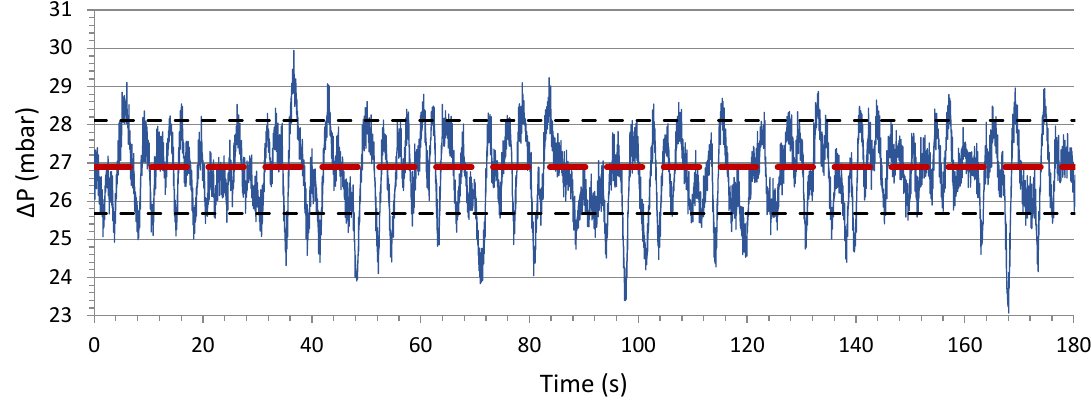
Figure 4. Example of a temporal differential pressure signal during a test. The dashed red line indicates the mean value of the signal, and the black ones correspond to the associated standard deviation, i.e., the fluctuations.